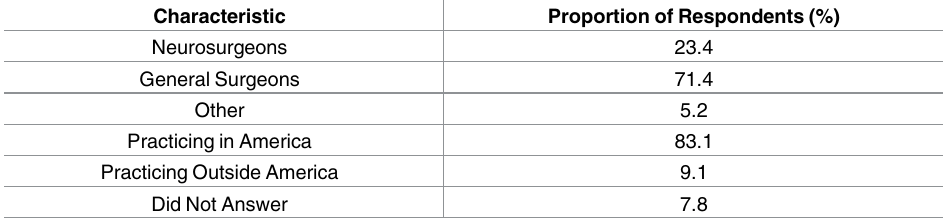
Table 1. Characteristics of survey